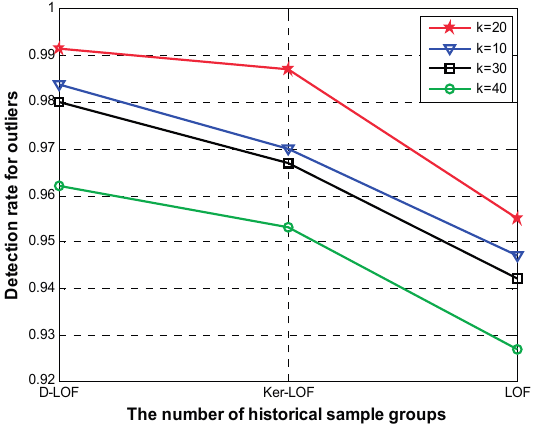
Figure 3. Detection rate for outliers with different k values.